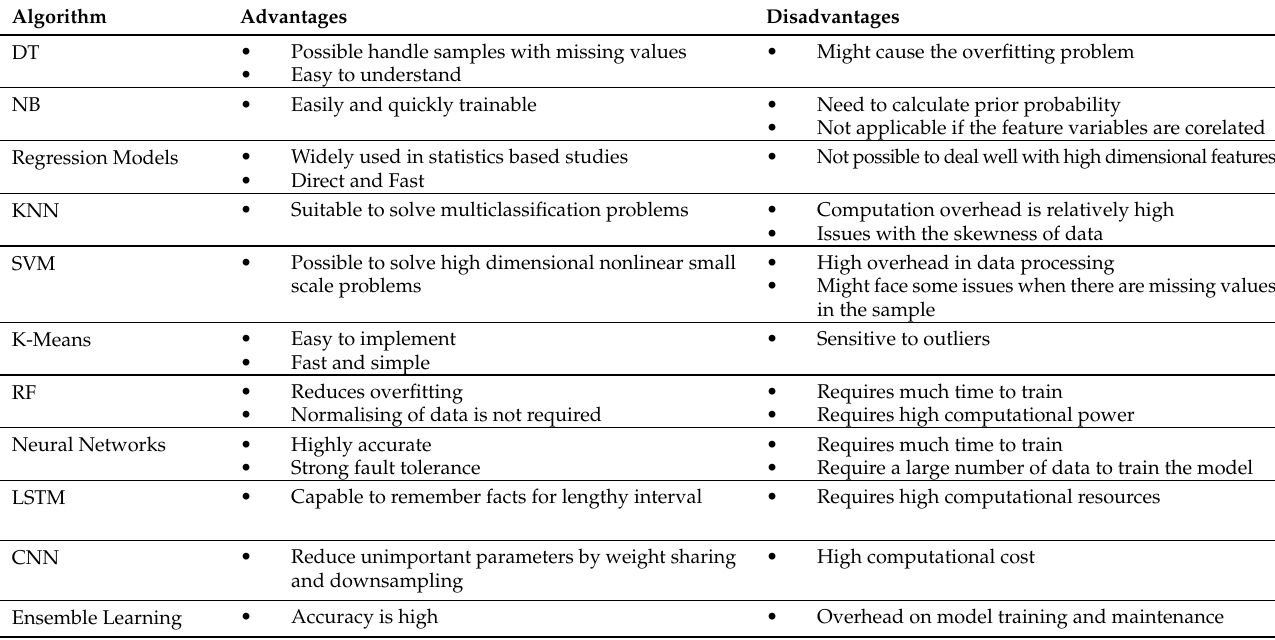
Figure 6. Usage of datasets. Table 12. Commonly used ML/DL algorithms for Android malware